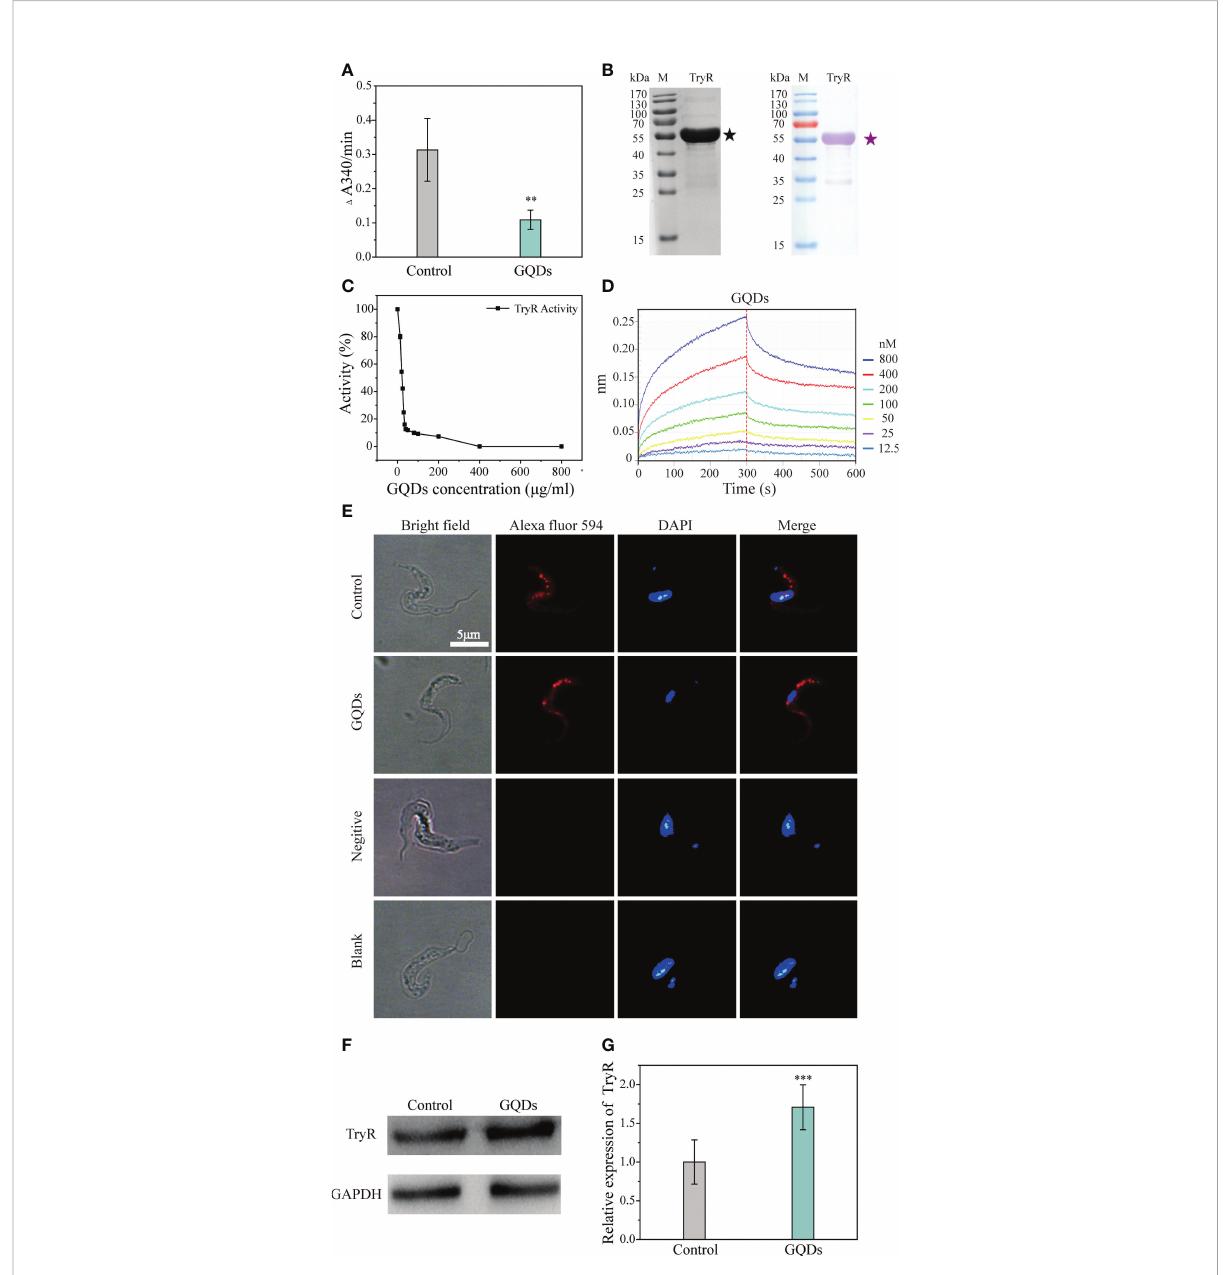
FIGURE 6 Direct af fi nity analysis and functional inhibition of the trypanothione reductase (TryR) of Trypanosoma brucei by graphene quantum dots (GQDs). (A) The catalytic activity of total parasite lysate was depressed in T. brucei , represented by the reduction of trypanothione after treatment with GQDs. The lysate of T. brucei not exposed to GQDs served as the control. (B) Analysis of the puri fi ed recombinant TryR protein using SDS-PAGE ( left ) and Western blotting ( right ). (C) GQDs treatment inhibited the catalytic activity of the recombinant TryR of T. brucei in a concentration-dependent manner. (D) Label-free binding of GQDs to the immobilized His-tagged recombinant TryR (TryR-His) in the Octet. To describe the intensity of the binding af fi nity between the two compounds, the equilibrium dissociation constant ( K d ) was calculated with k dis / k on . K d values from 1.0E − 03 to 1.0E − 12 M indicate that two compounds are interacting (Supplementary Table S2). (E) Distribution of TryR in the parasites evaluated by immuno fl uorescence assay. A mouse anti-TryR IgG and Alexa Fluor 594-conjugated goat anti-mouse IgG were employed as the primary and secondary antibodies, respectively. Nuclei and kinetoplasts were stained with DAPI. The buffer without antibodies and unimmunized mouse serum were used as the blank and negative controls, respectively. Cyan indicates saturated pixels. (F) Increased intracellular accumulation of TryR in T. brucei after GQDs treatment as revealed by Western blotting analysis. GADPH was adopted as the control. (G) Densitometric analysis of the gray images in (F) using ImageJ software (v1.8.0). All values are the mean ± SD of triplicates. Student ’ s t -test was used to obtain p -values. *** p < 0.001 (compared to the control)